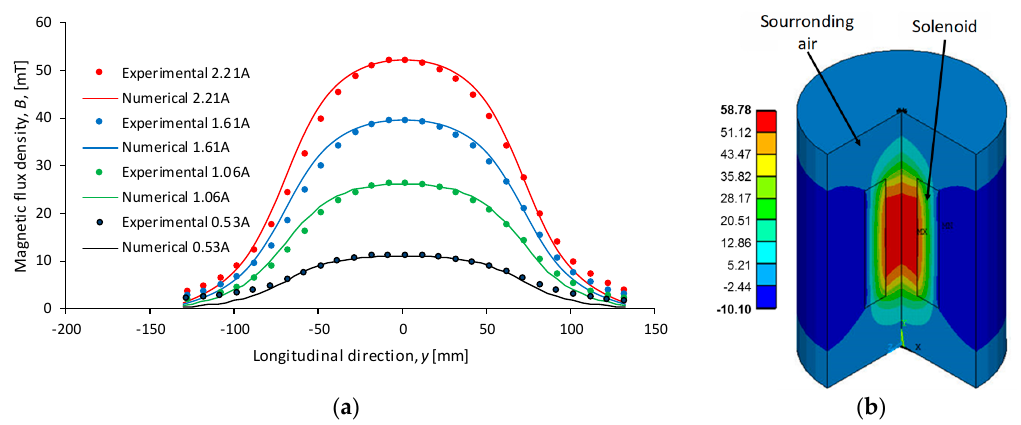
Figure 2. ( a ) Comparison between experimental measurements and numerical results of the magnetic flux density along the solenoid longitudinal axis y . As expected, a linear relationship between the electrical current applied to the solenoid and flux density is observed. ( b ) Computed magnetic flux density (mT) in the solenoid and surrounded air, these results were obtained numerically by solving the Maxwell equations, using ANSYS finite element method software.